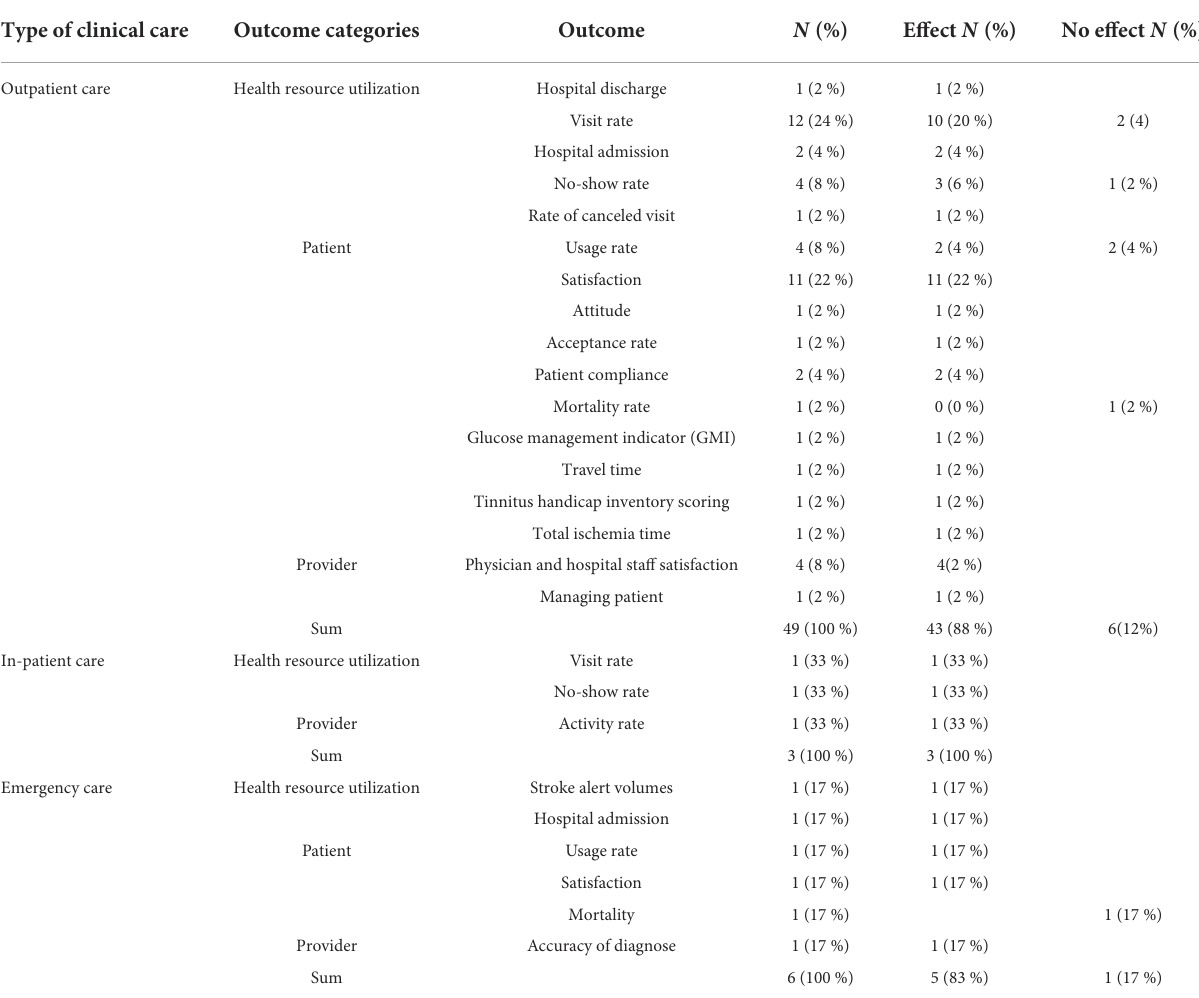
TABLE 4 Classification of outcome measures based on clinical